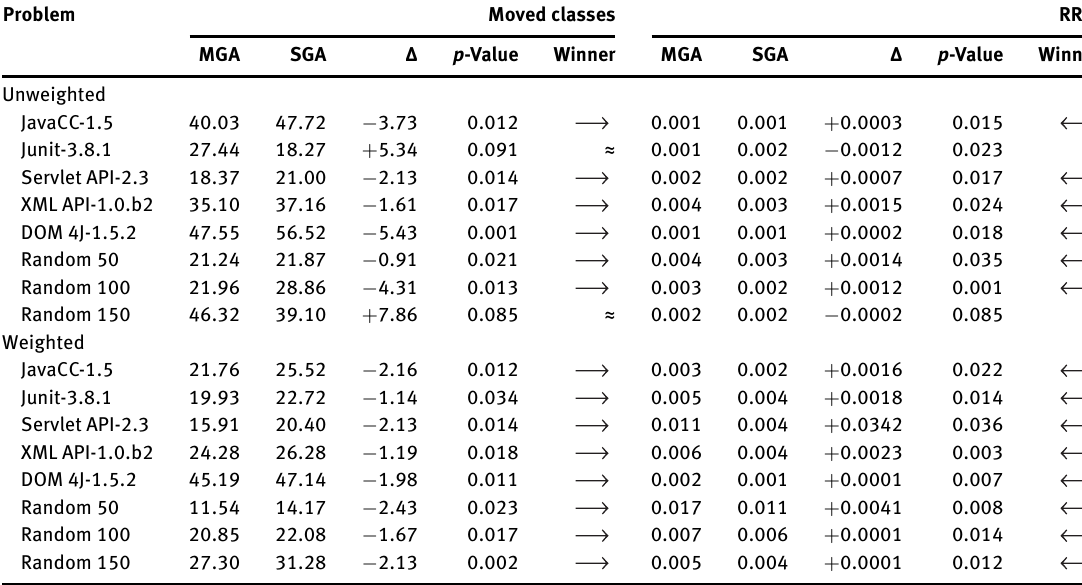
Table 4: Mean Values of Moved Classes and RRAI in Global Optimization. Problem